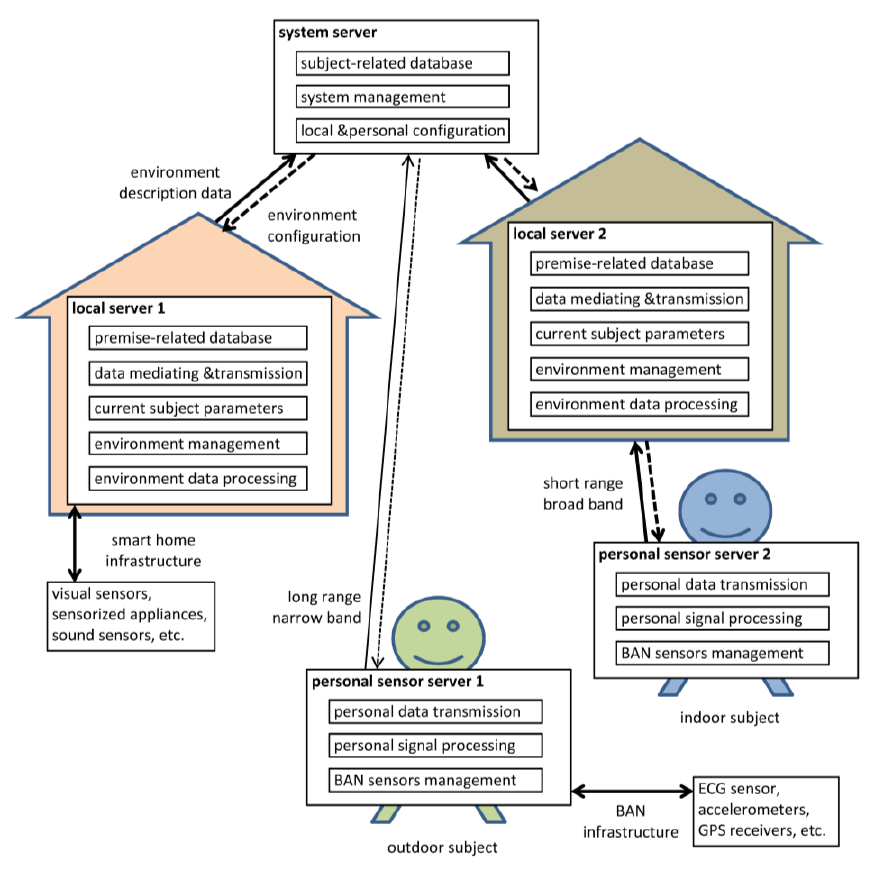
Figure 1. Backbone architecture of the surveillance